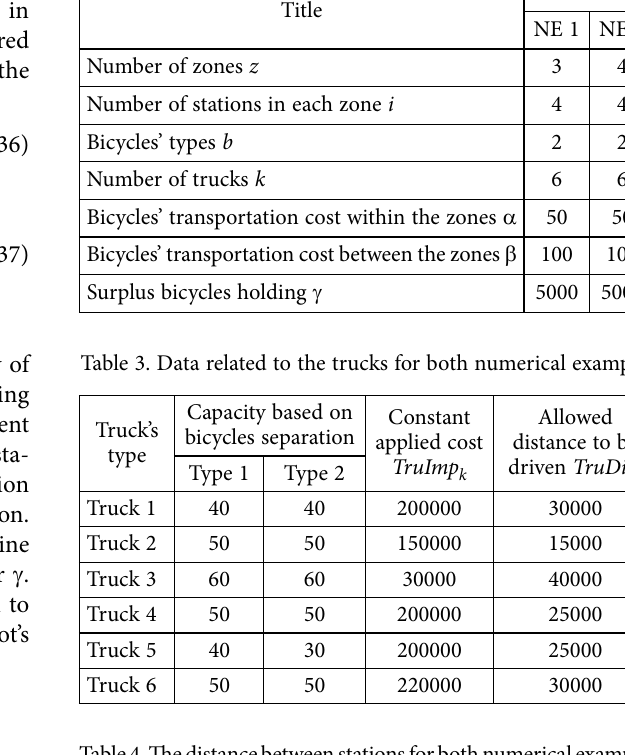
Table 4. The distance between stations for both numerical